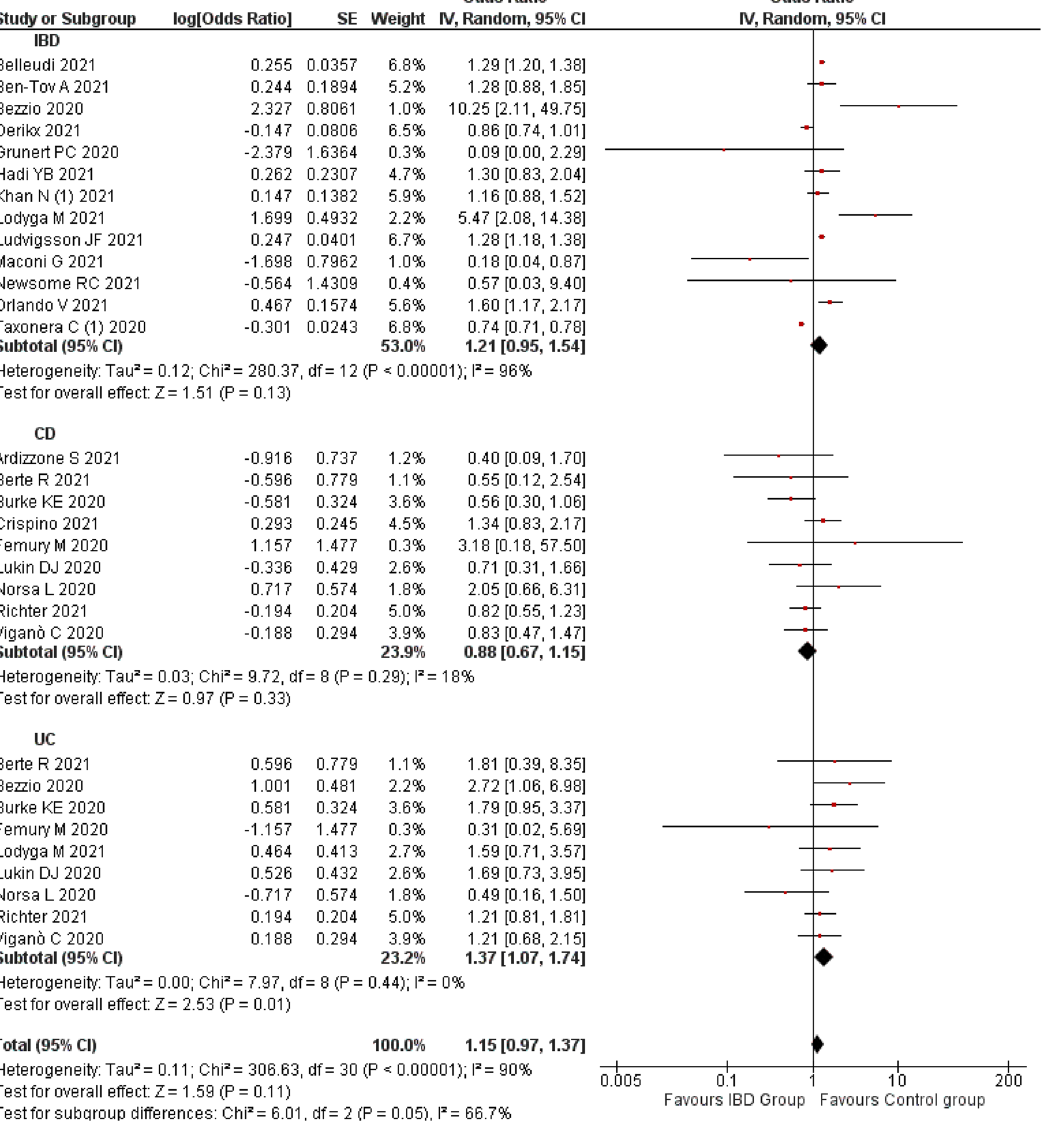
Figure 3. Risk of COVID-19 among the IBD